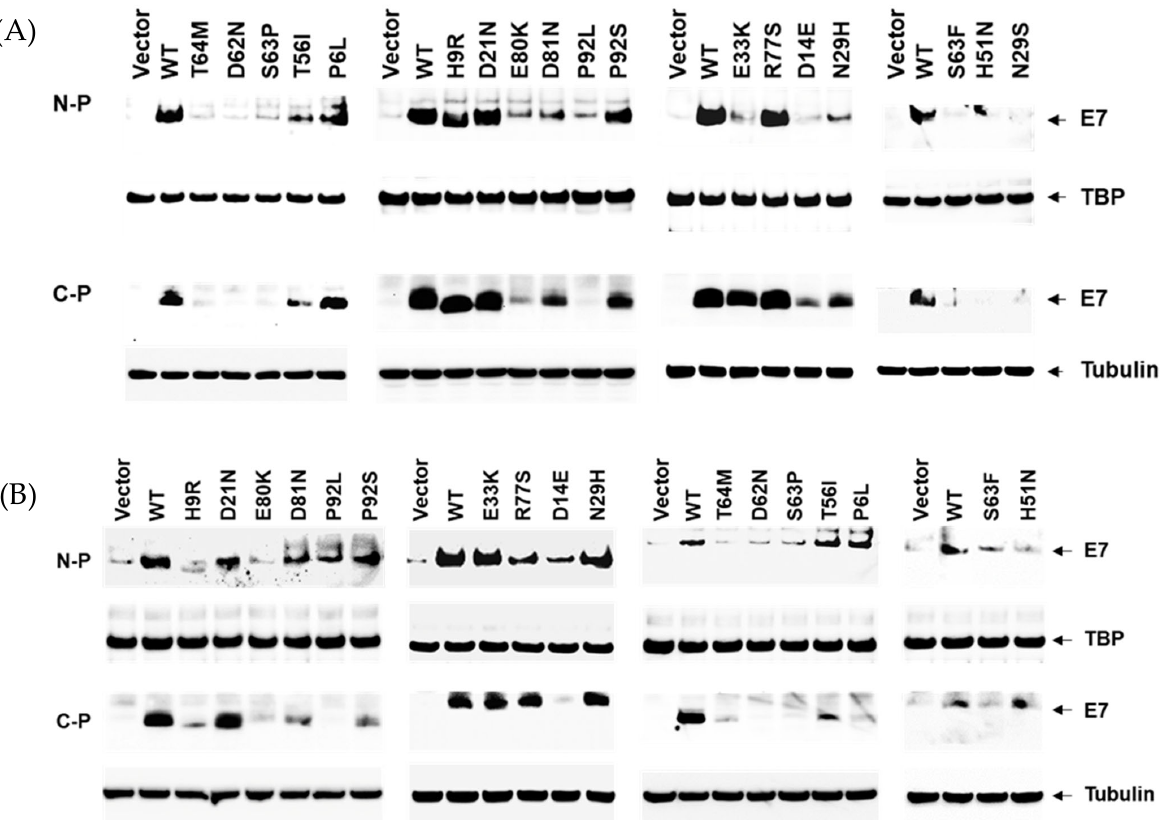
Figure 2. Western blot analyses of HPV16 E7 from HeLa ( A ) and 293T ( B ) cells transiently transfected with empty vector, wild-type and indicated mutant E7 constructs. The position of the E7, Tubulin and TBP (TATA binding protein) are indicated. N-P and C-P represent the nuclear and cytoplasm proteins, respectively. Statistical analysis of three independent experiments is shown in Figure S2.